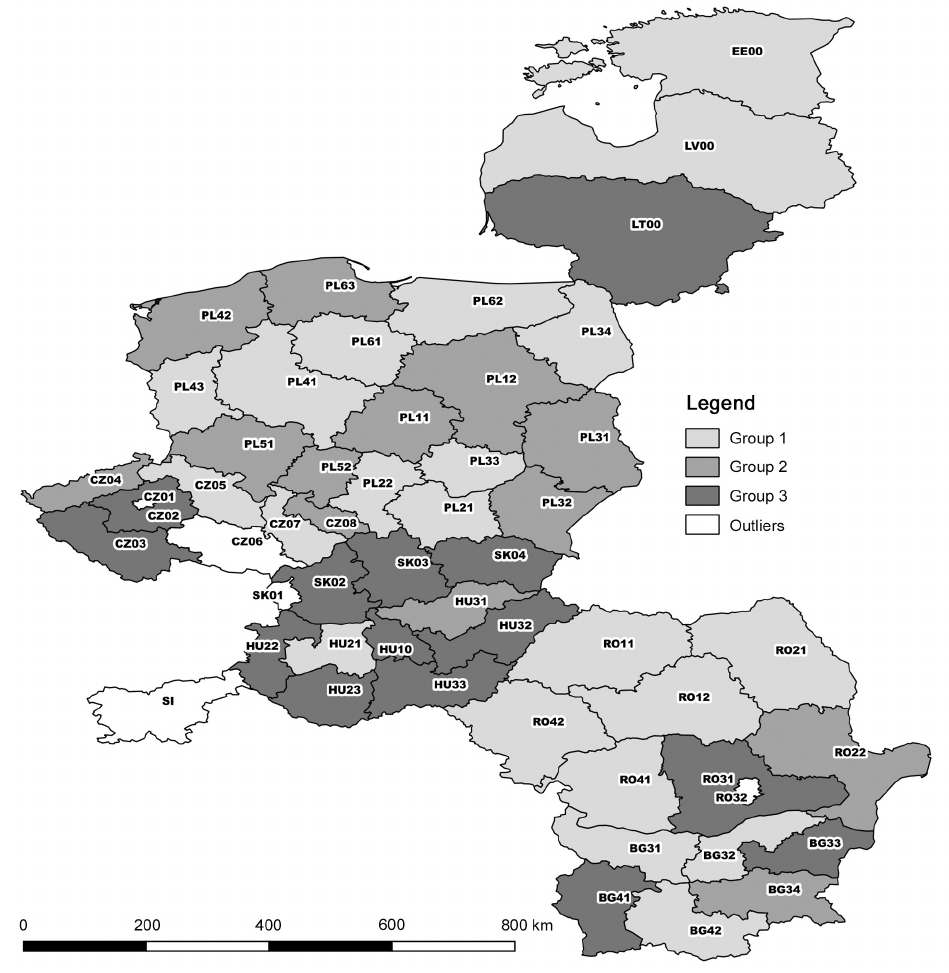
Fig. 5. K-means clustering of CEE regions. Source: own calculations based on Eurostat